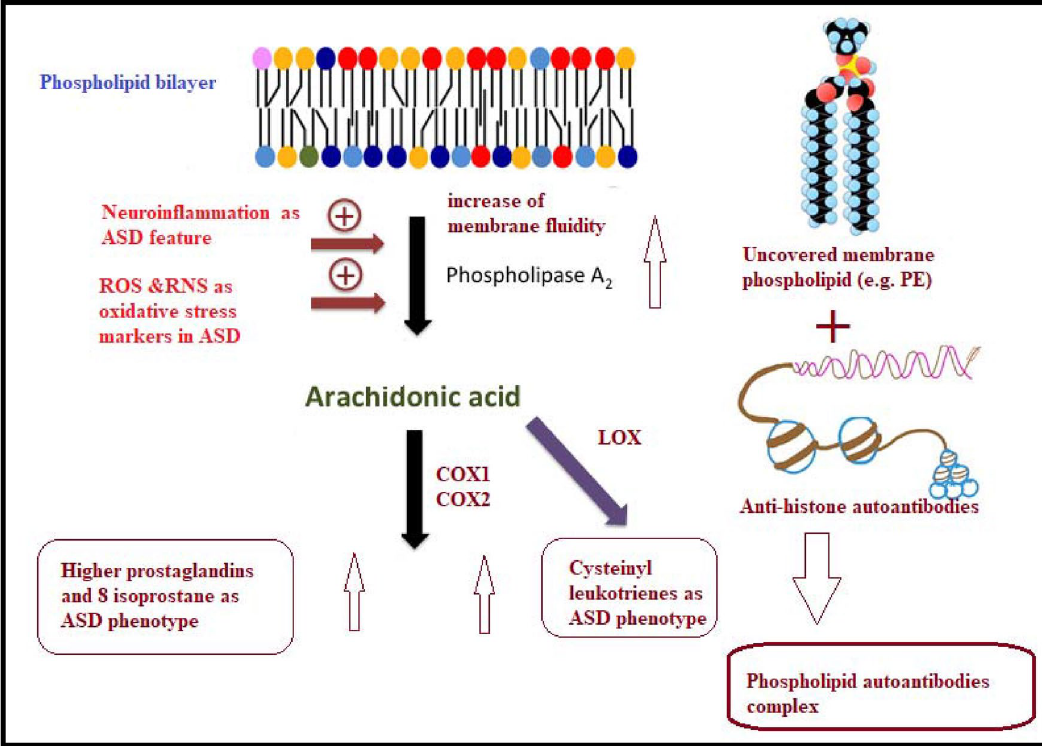
Figure 8. Illustration of the suggested relationship between combined anti-histone autoantibodies, and PLA2/ PE relative ratio in inducing neuronal damage. In response to neuroinflammation and oxidative stress, induced elevation of PLA2 as phospholipid hydrolysing enzyme can trigger the elevation of pro-inflammatory lipid mediators (Cysteinyl leukotrienes, and prostaglandins) as ASD phenotype. Suggested influx of anti-histone autoantibodies from plasma to brain through the disrupted BBB induces the formation of PE-anti-histone autoantibodies complex which increases anti-phospholipid antibody levels and greatly affects membrane